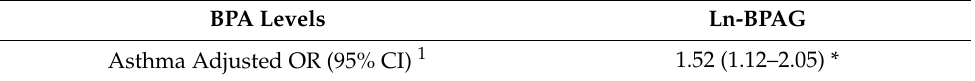
Table 6. The association of BPA exposure with asthma in children ( N =